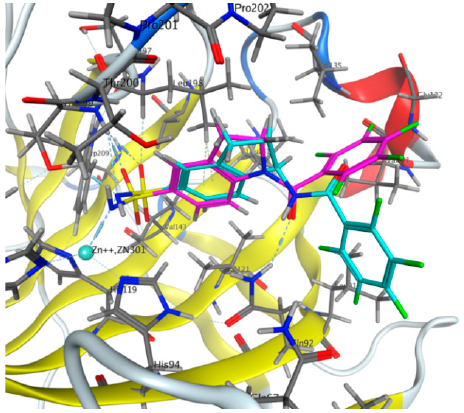
Figure 2. Scaffold hopping approach for the design of novel CA inhibitors based on indoline-5- sulfonamide core 4 .